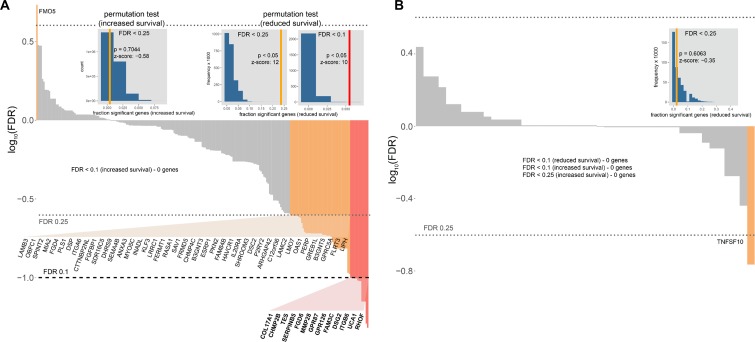
Association of HNF1A-responsive genes and survival in PDA.(A, B) HNF1A-responsive genes were ranked according FDR-adjusted Wald p value and the direction of survival association using TCGA PDA patient data for (A) upregulated genes (including bound and unbound) and (B) downregulated genes. Each bar represents the Cox proportional hazards model for one gene; its magnitude indicates significance (log10-transformed adjusted p values), and its sign represents the hazard ratio (a negative value means that HR >1 and hence reduced survival). Red bars indicate FDR < 0.1, orange bars indicate FDR < 0.25, and gray bars are not significant. The FDR thresholds are also indicated by dotted horizontal lines. Permutation test insets: the histograms represent the null distribution for fraction of genes significantly associated with either increased or reduced survival and at FDR < 0.1 or FDR < 0.25 (as indicated). Vertical lines represent the value for the set of HNF1A upregulated or downregulated genes, respectively; red for the FDR < 0.1 test, orange for the FDR < 0.25 test). * - indicates significant p values for the permutation tests. N = 10,000 for all permutations and the estimated error of p at α = 0.05 is ±0.0034.